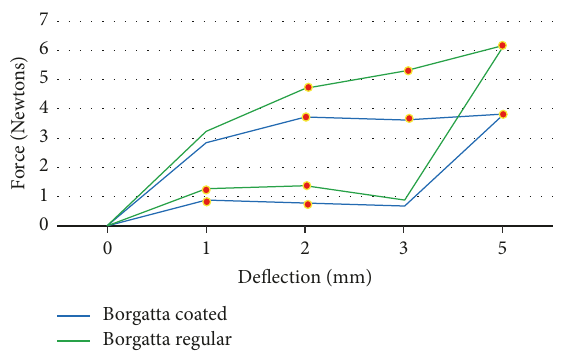
Figure 2: Comparison of the mean force (N) load and unload deflection between the coated and regular Ni-Ti TP round 0.016 󸀠󸀠 wires. There was a statistically significant decrease in the coated wire at 2mm ( 𝑝 < 0.01 ) and 3 mm ( 𝑝 < 0.01 ) load deflection; for an unload deflection at 2 mm, a decrease ( 𝑝 < 0.01 ) was observed, while, at 3 mm, an increase ( 𝑝 < 0.01 ) was found compared to regular Ni-Ti wires.